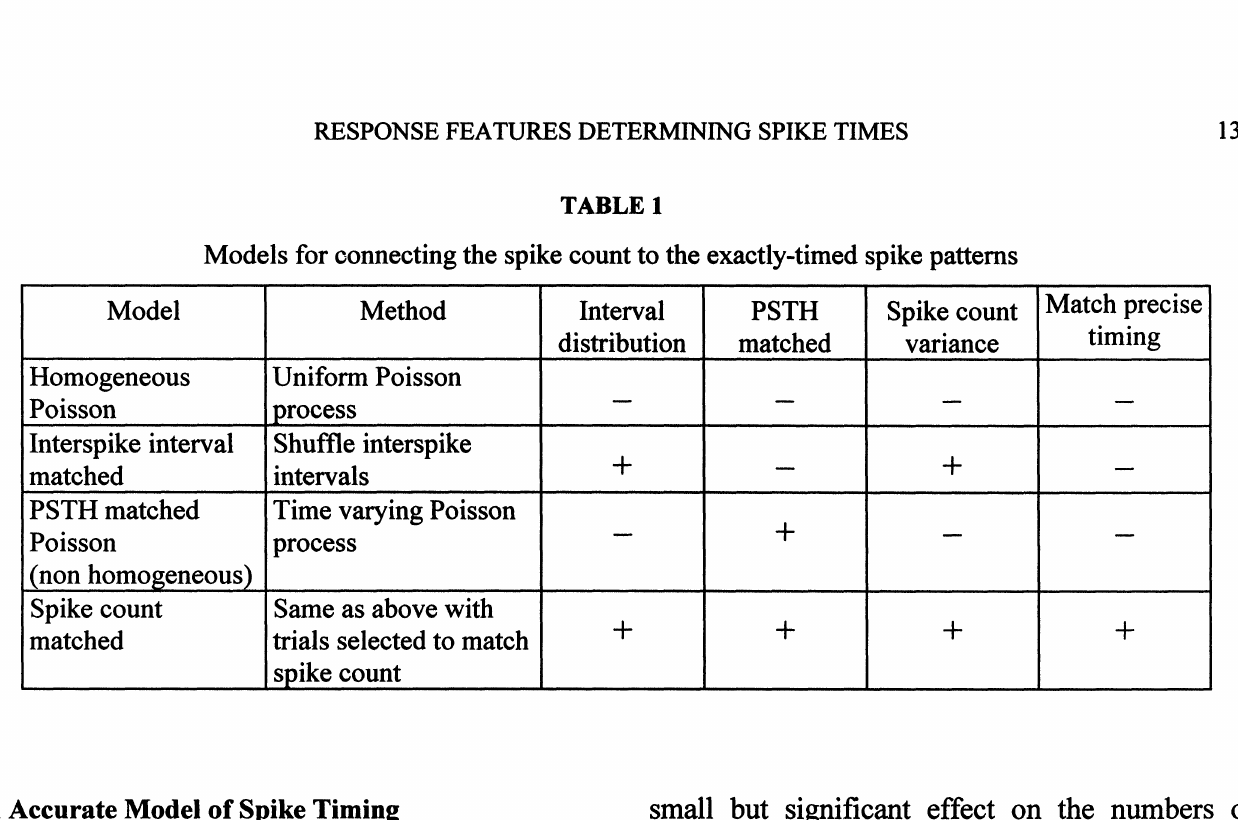
Models for connecting the spike count to the exactly-timed spike patterns